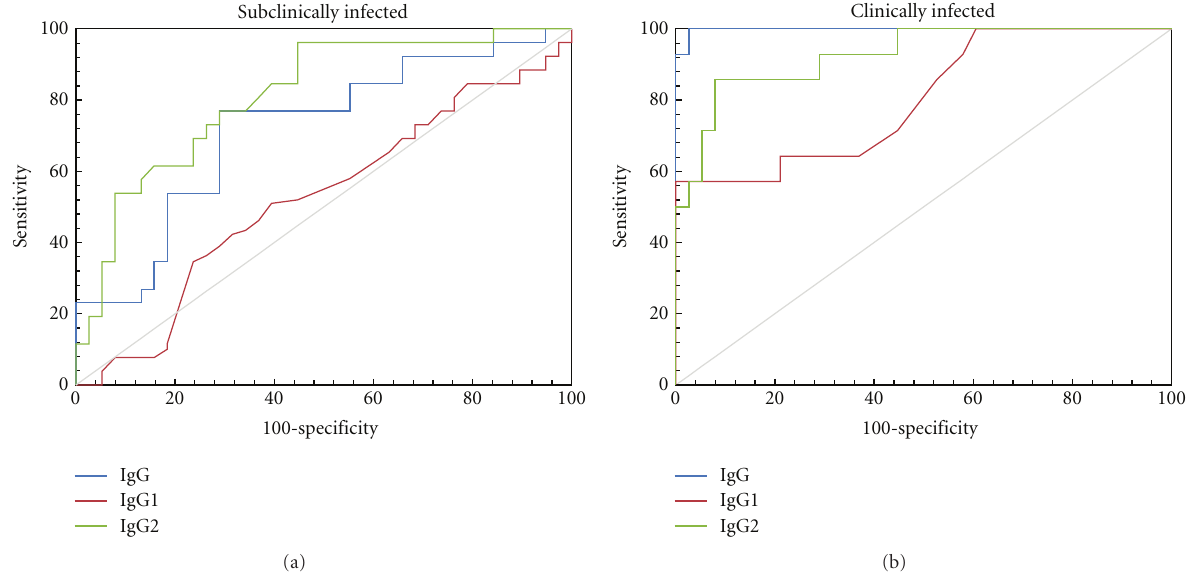
Figure 2: Performances of isotypes/PPA-ELISAs for subclinically infected (a) and clinically infected cattle (b). Receiver-operating characteristic (ROC) curves for IgG, IgG1, and IgG2/PPA-ELISAs. Table 1: Percentages of positivity of isotypes/PPA-ELISAs. Groups IgG/PPA-ELISA IgG1/PPA-ELISA IgG2/PPA-ELISA